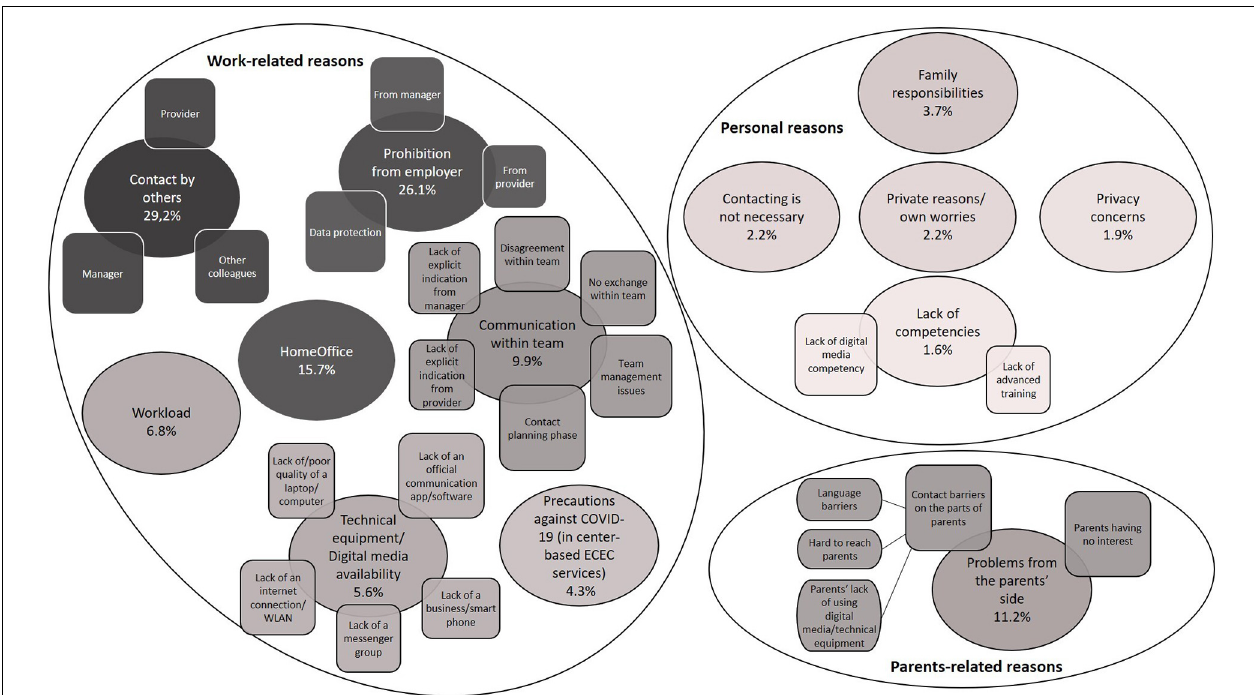
FIGURE 2 | ECEC professionals’ reasons for not being in contact with parents. The categories are divided, based on comprehensive thematic dimensions, with large circles. Inside each large circle, the main categories are shown as circles, while subcategories are illustrated as squares. The categories change from dark to light according to the frequency of the assigned